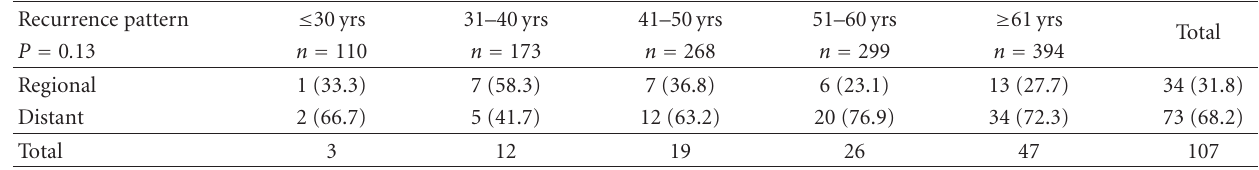
Table 3: Regional versus distant recurrence based on decade of age, (including only SLN NEG, n = 107).